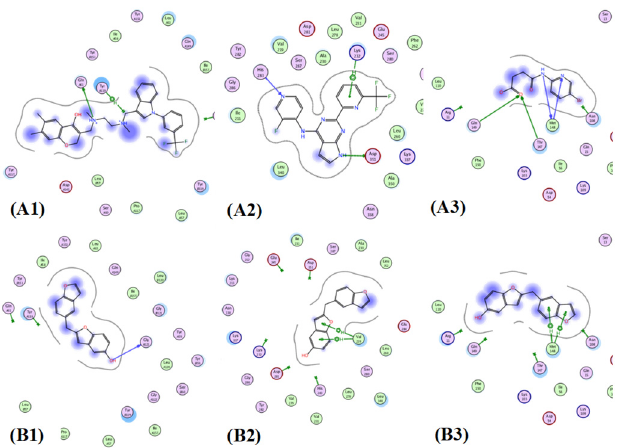
Figure 13. Showing 2D-binding interactions of co-crystallized ligand ( A1 – A3 ) and compound 1 ( B1 – B3 ) within active sites of: TNF α (PDB ID: 2AZ5); TGFBR1 kinase (PDB ID: 6B8Y); and IL-1 β (PDB ID: 6Y8M).